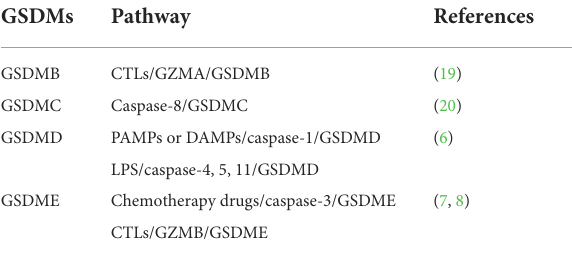
TABLE 1 GSDMs and their pathway of